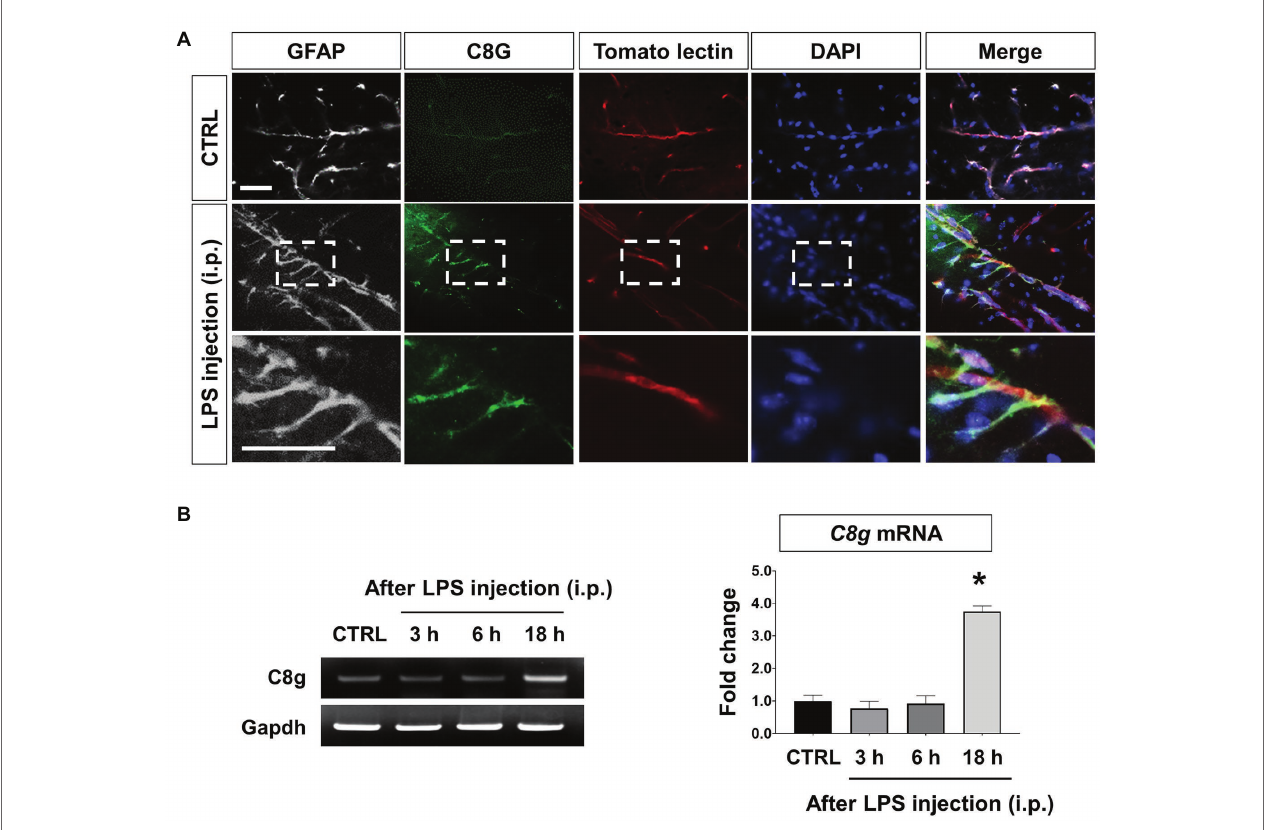
FIGURE 1 | Component 8 gamma (C8G) expression in perivascular astrocytes in the lipopolysaccharide (LPS)-induced inflamed brain. (A) Immunofluorescence analysis of C8G in the hippocampus (green). An anti-GFAP antibody was used as a marker of astrocytes (gray). Tomato lectin stains brain blood vessels (red). Mice were injected with LPS (5 mg/kg) intraperitoneally (i.p.). Scale bar, 25 μ m. (B) Time course of the C8G mRNA expression in the inflamed brain ( n = 3). Data are the mean ± SEM. * p < 0.05 vs. the control (CTRL), Dunnett’s multiple comparison post hoc test after one-way